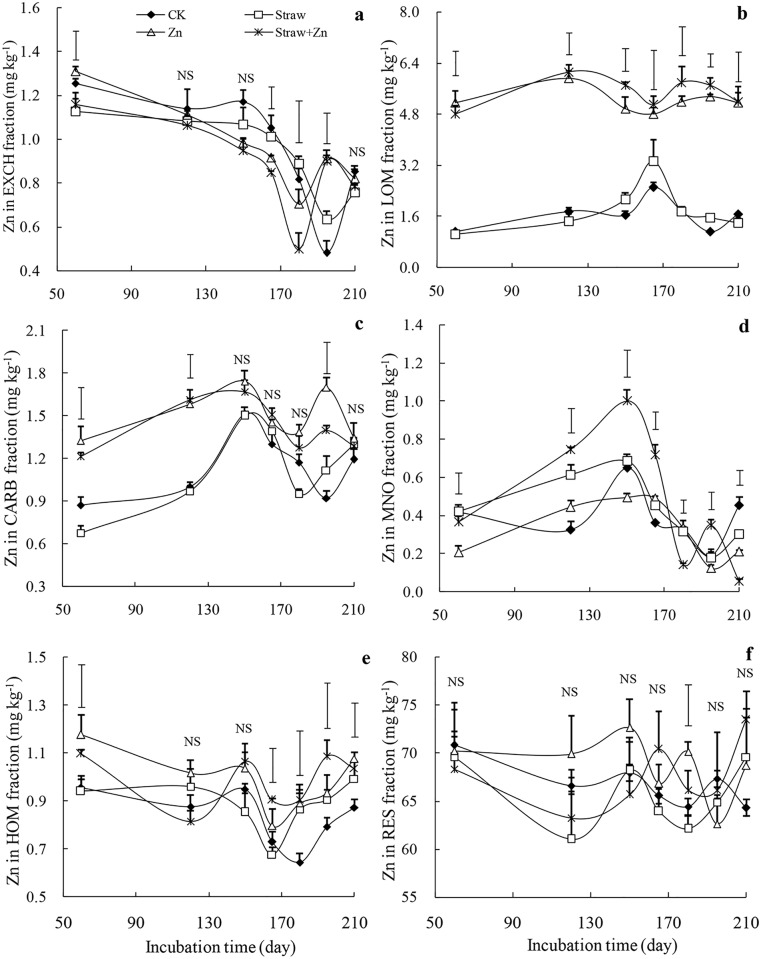
Zn concentration among the fractions in soils with exogenous Zn and straw applications.Soil total Zn was separated into the Zn in exchangeable (EXCH, a), organic matter with low bonding forces (LOM, b), carbonate (CARB, c), manganese oxide (MNO, d), organic matter with high bonding forces (HOM, e), and residual (RES, f) fractions by a sequential extraction procedure. The bars on the curves are standard errors (n = 3) and the bars above the curves represent the least significant difference (LSD) at 5% and "NS" means no significant difference.